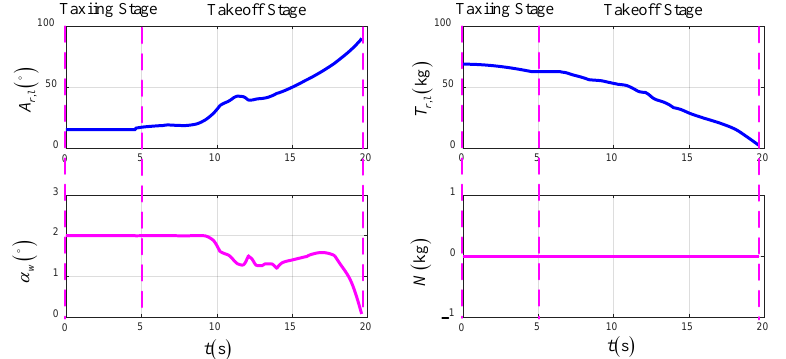
Figure 17. The control variables in STO.